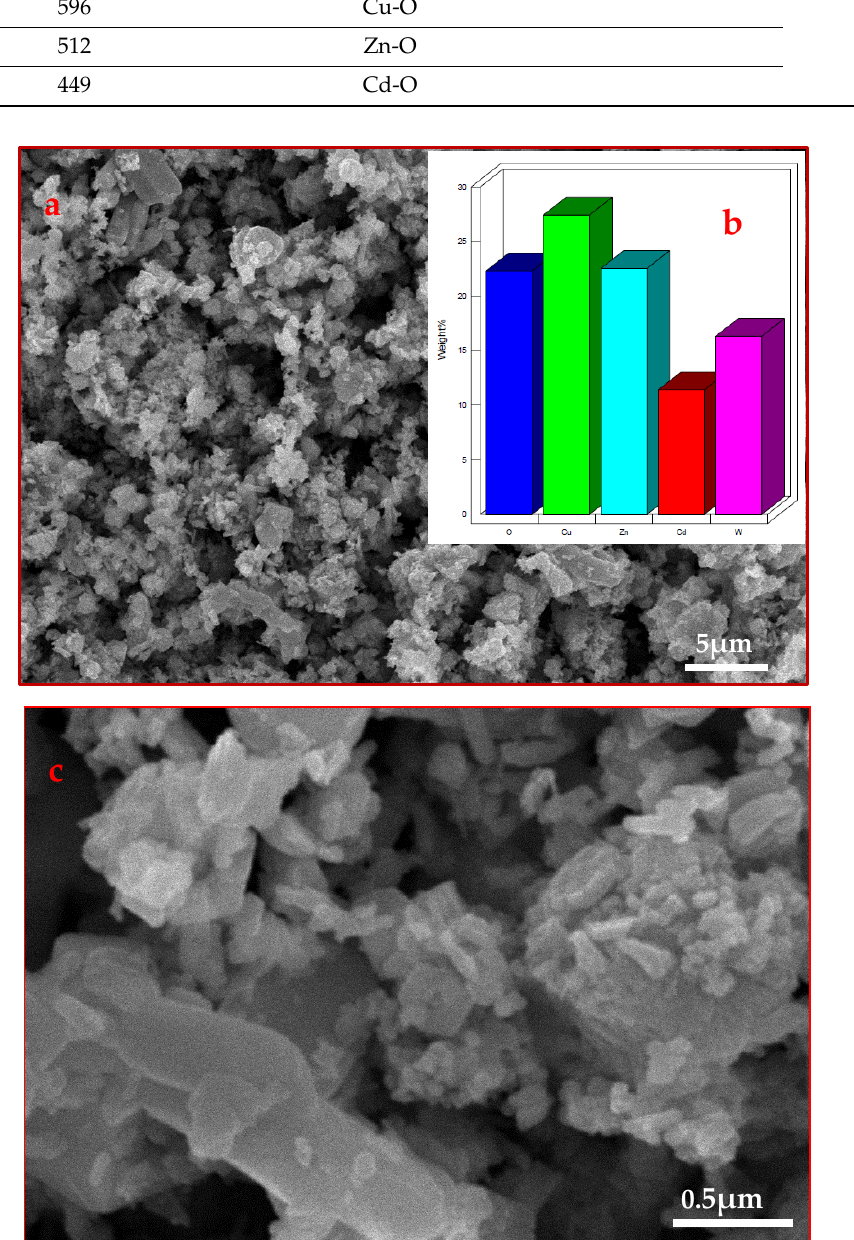
Figure 2. SEM images ( a , c ) of Cu-ZnBO-Cp-CT at different magnifications (inset ( b ) shows the elemental composition).